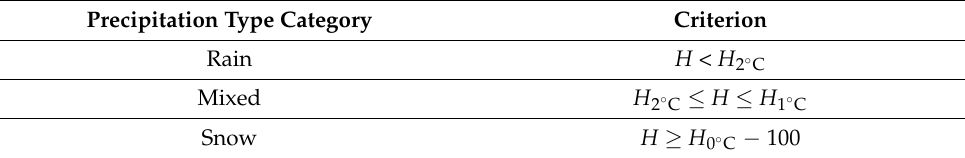
Table 4. Criteria adopted for precipitation type categorization. If a determined grid cell is affected by precipitation, it is assigned to rain if H < H 2°C , to mixed precipitation type if H 2°C ≤ H ≤ H 1°C and to snow if H ≥ H 0°C − 100, where H is the altitude (expressed in m asl) of a determined composite grid cell and H 0°C , H 1°C and H 2°C are the altitudes of 0 °C, 1 °C and 2 °C isotherms.